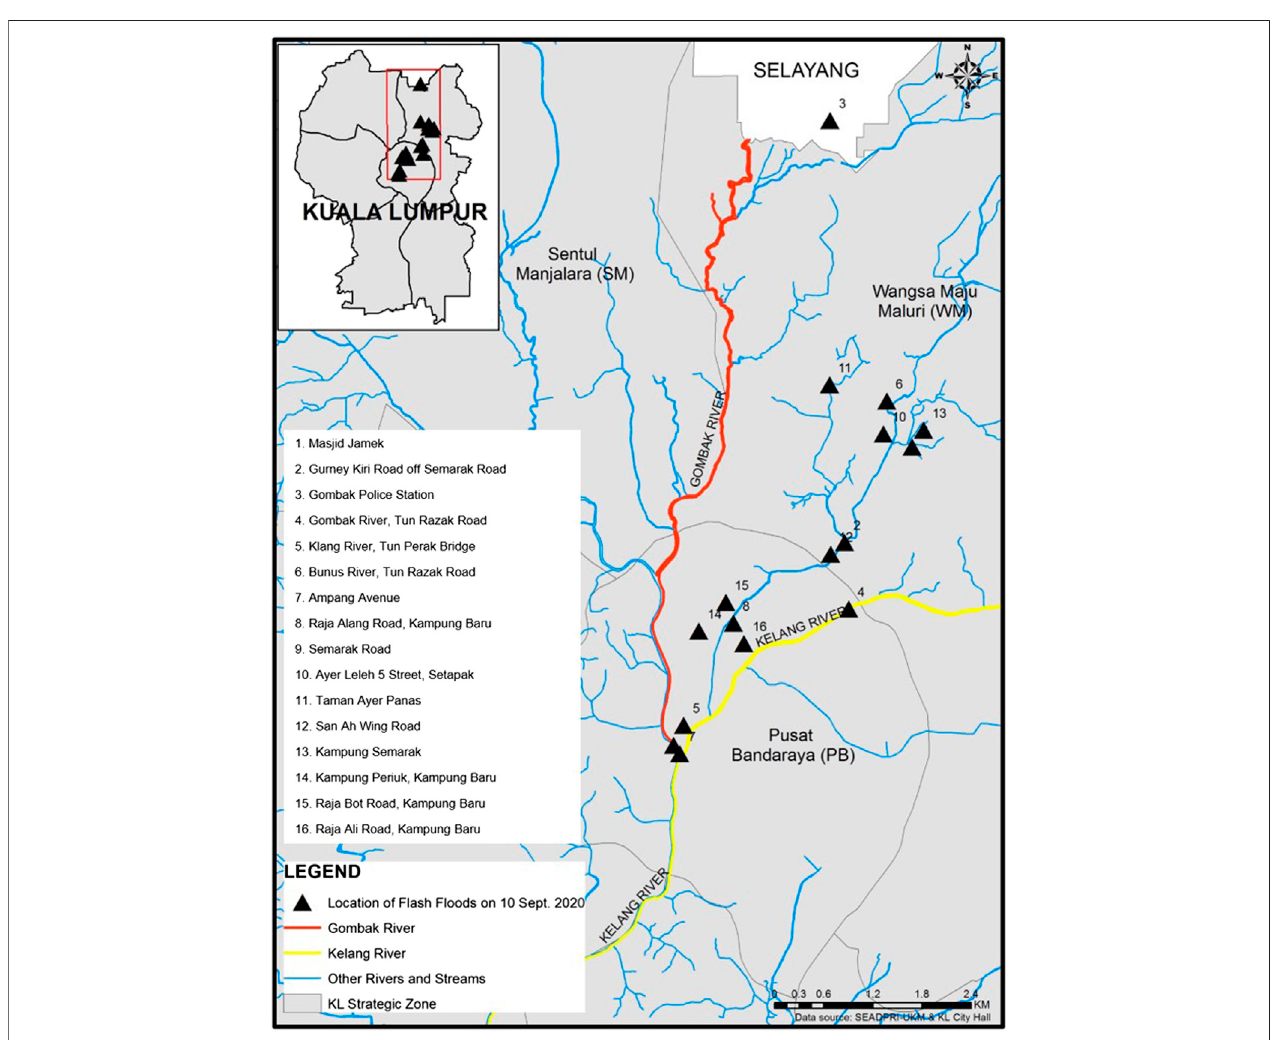
FIGURE 3 | The location of inundated vicinities due to fl ash fl oods and water ponding in Kuala Lumpur on September 10, 2020.